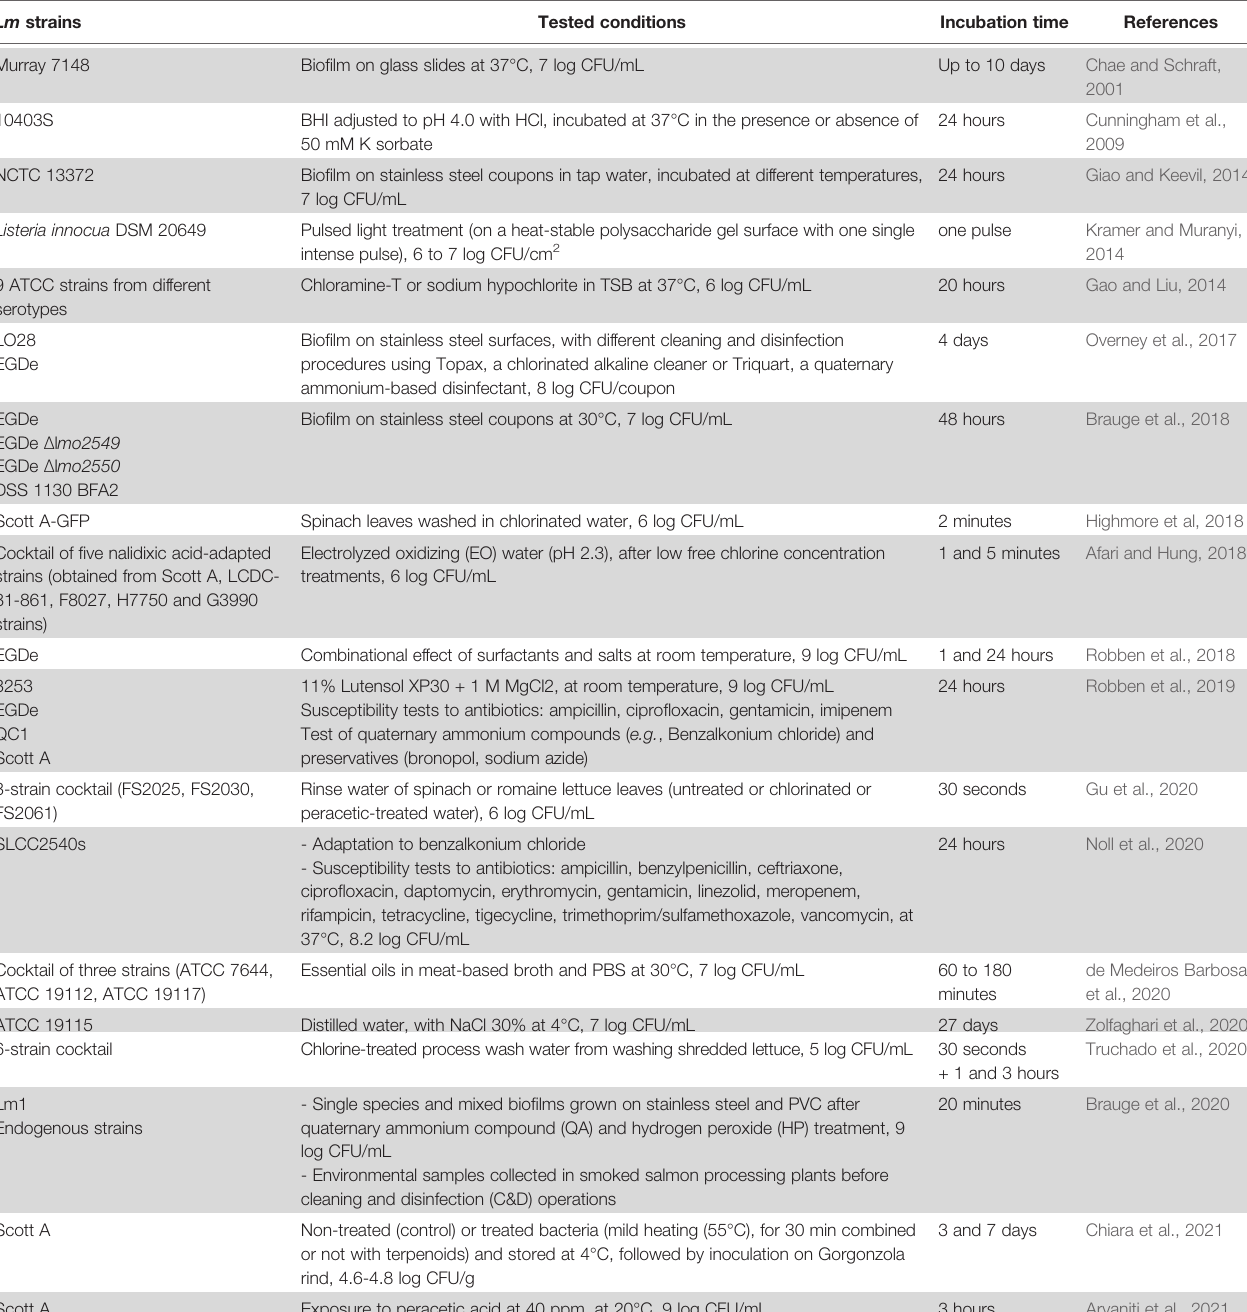
TABLE 5 | VBNC Lm induced by antimicrobials and/or in bio fi lms. Lm